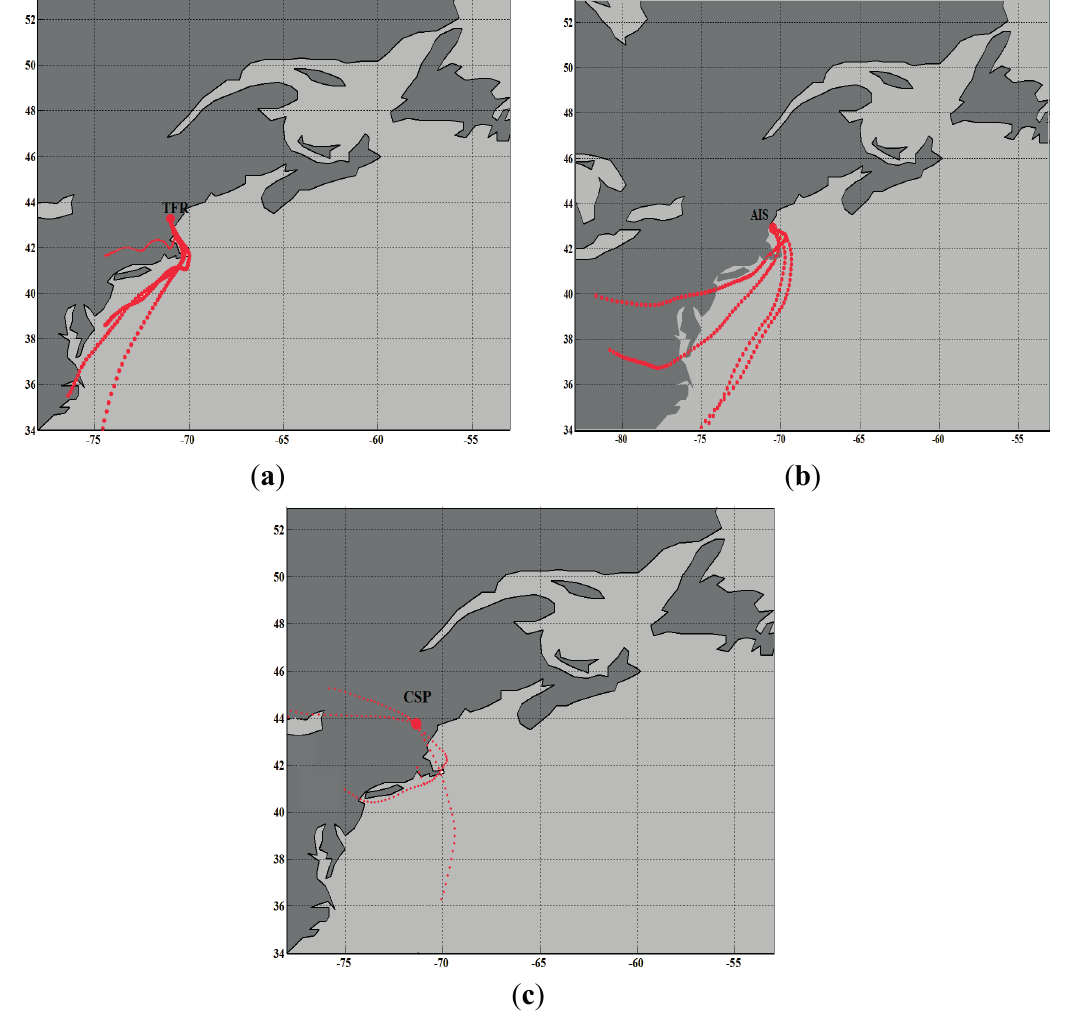
Figure 12. Lagrangian back trajectories from the NOAA HYSPLIT model for 36 h prior to the plume mixing inland on 7/21. Shown are trajectories for ( a ) TFR; ( b ) AIS; and ( c ) CSP AIRMAP stations used in the inland